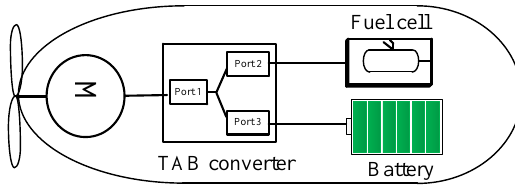
Figure 21. Proposed TAB converter for autonomous underwater vehicles (AUVs).